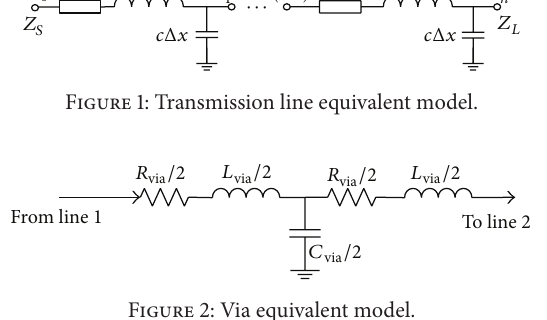
Figure 2: Via equivalent